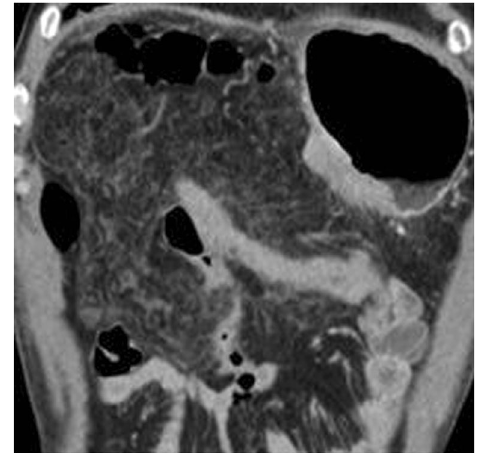
Fig. 13 Fat stranding. Coronal CT image in the immediate postoperative period shows a diffuse stranding of the mesenteric fat